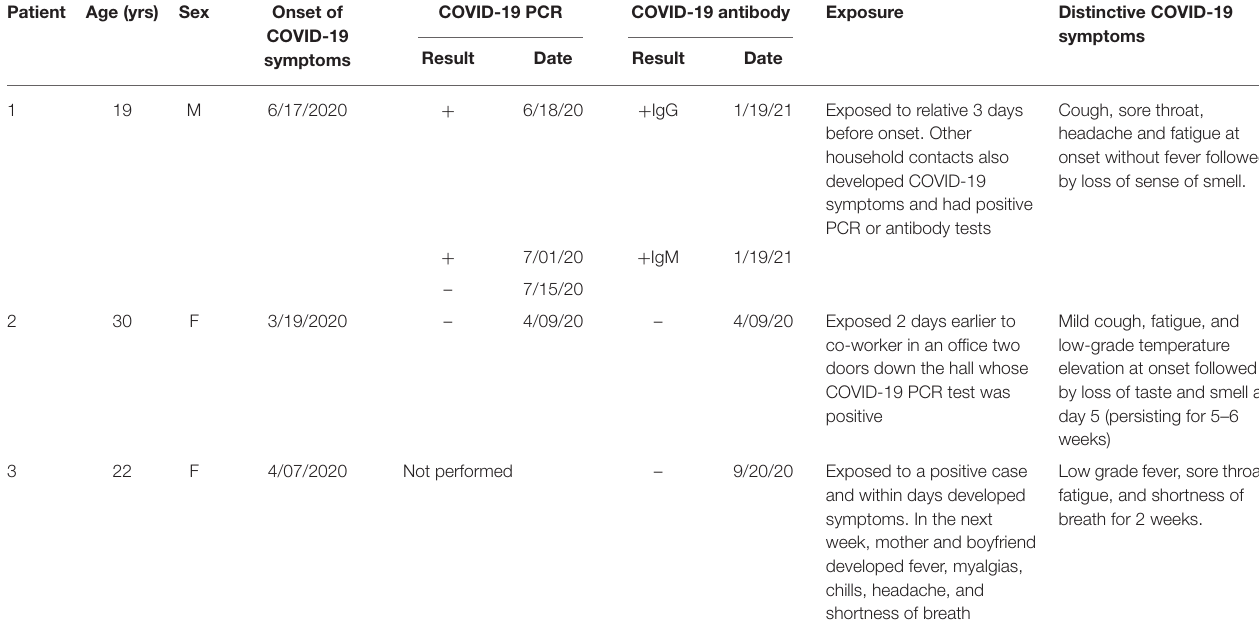
TABLE 1 | Onset, diagnostic testing, and clinical features of confirmed and probable COVID-19 infection in the study participants. Patient Age (yrs)